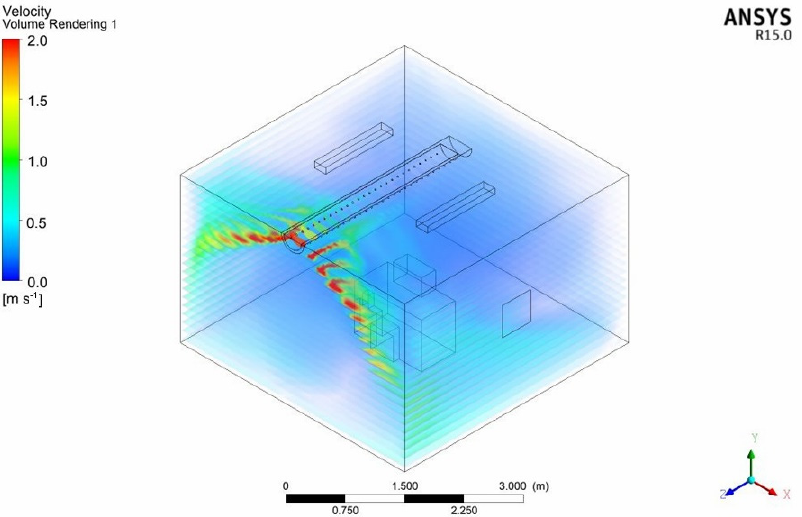
Figure 7. The schematic diagram of the air supply of the double-row hole split-fiber air conditioner.